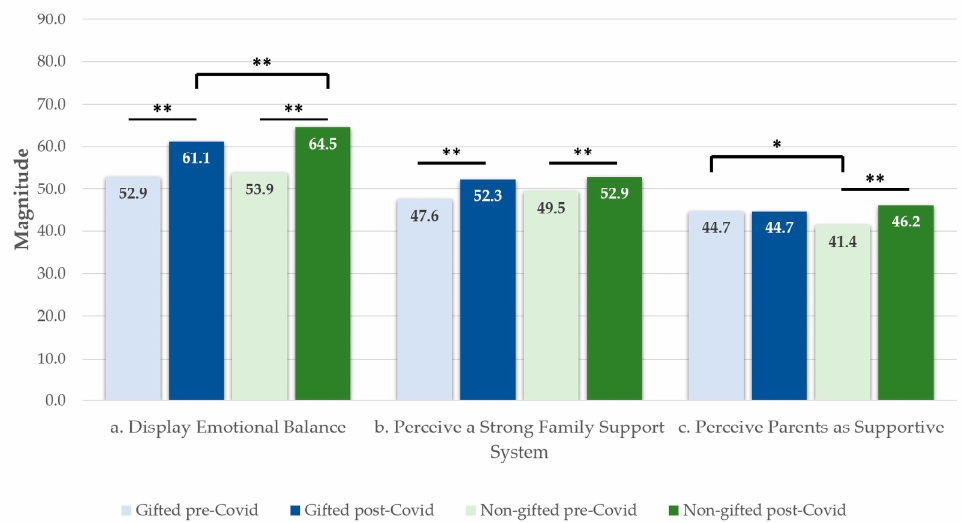
Figure 1. Pre- and post-COVID-19 social and emotional stability in gifted and non-gifted children (Student’s t -test, * p < 0.05, ** p < 0.01). The three metrics are represented in the figure. Bars represent values within each study group.